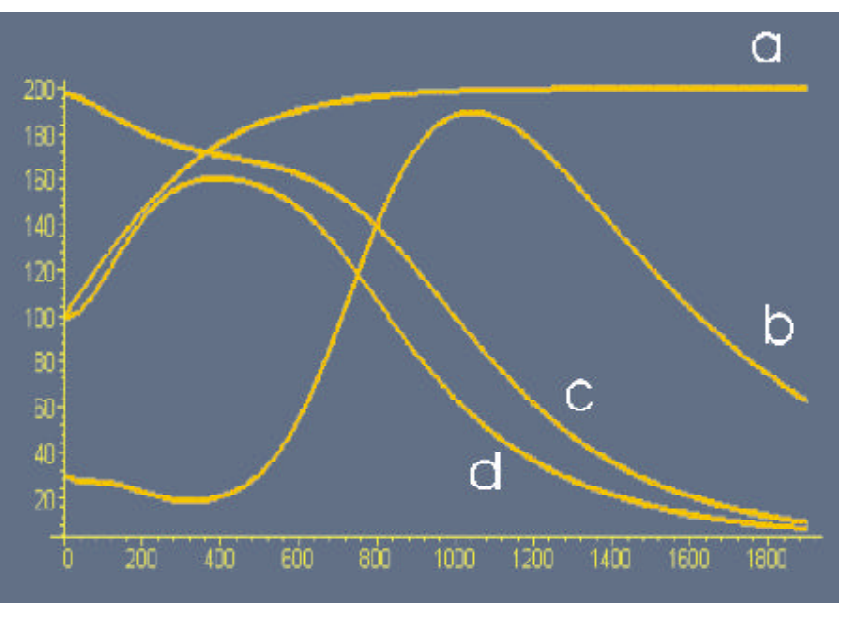
FIGURE 3. Substrate metabolization: (a) toxic substrate concentration, (b) biomass, (c) influent substrate concentration, (d) bioreactor substrate